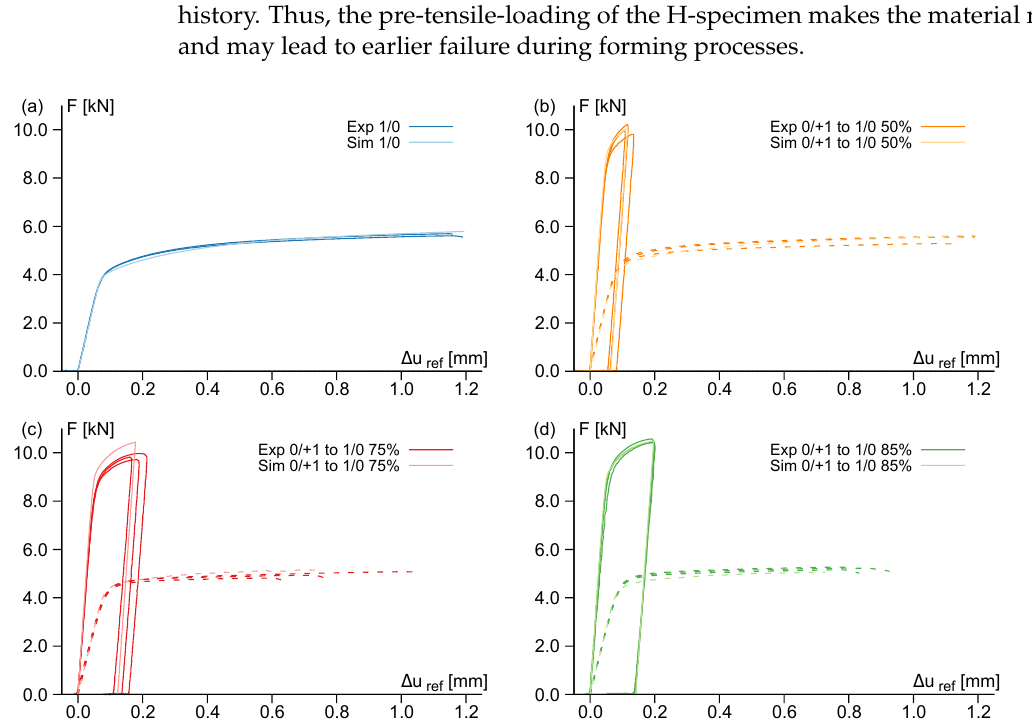
Figure 4. Load-displacement curves for F 1 / F 2 = 1/0 with different preloadings. In the second series of alternative load paths (EXP 1/0 to 0/+1), the H-specimens are initially loaded by F 1 , and this process stops when 45%, 65%, or 90% of the final displacement ∆ u ref .1 of EXP 1/0 has been reached (solid line in Figure 5). After unloading, the specimens are loaded in a second step by F 2 up to final fracture (dotted line in Figure 5). Figure 5 shows how the different preloadings affect the load-displacement curves of the final load path. In particular, if preloading of 45% of the final displacement ∆ u ref .1 is taken into account (EXP 1/0 to 0/+1 45%), the maximum load in the second step is F 2 = 11.7 kN (Figure 5b), which is an increase in load of about 15% compared to the respective basic test. After unloading of the first step, the displacement in axis 2 is ∆ u ref .2 = − 0.02 mm, which increases up to ∆ u ref .2 = 0.16 mm, where the specimen failed. In the case of preloading with 65% of the final displacement ∆ u ref .1 (EXP 1/0 to 0/+1 65%), the maximum load is = 0.13 mm; see F 2 = 11.6 kN, and the displacement at onset of fracture reaches ∆ u ref .2 Figure 5c. And if preloading of 90% of the final displacement ∆ u ref .1 is considered (EXP 1/0 to 0/+1 90%), the maximum load in the second step of F 2 = 11.2 kN can be seen in Figure 5d, and the specimen failed at the displacement ∆ u ref .2 = 0.05 mm. Again, the different preloading histories remarkably affect the load-displacement behavior during the second load path with F 2 . In the case of pre-shear-loading, an increase of the load maxima of about 15% is measured. In addition, the relative displacements at failure are remarkably reduced and reach only about 20% of the displacements after the basic experiment without preloading. Thus, the pre-shear-loading of the H-specimen makes the material very brittle with only marginal further inelastic deformations. It can also be seen in Figures 4 and 5 that the load-displacement curves of the numerical simulations agree very well with the experimental